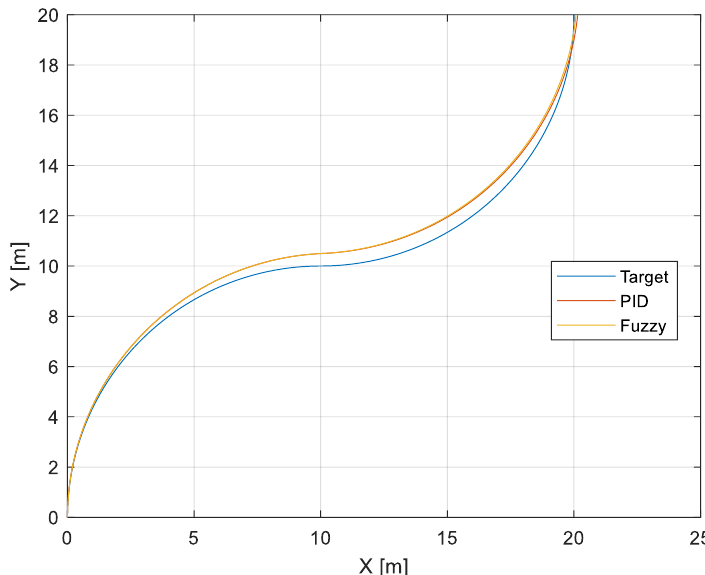
Figure 24. Comparison of the tracking of the s-shaped curve for both controllers.